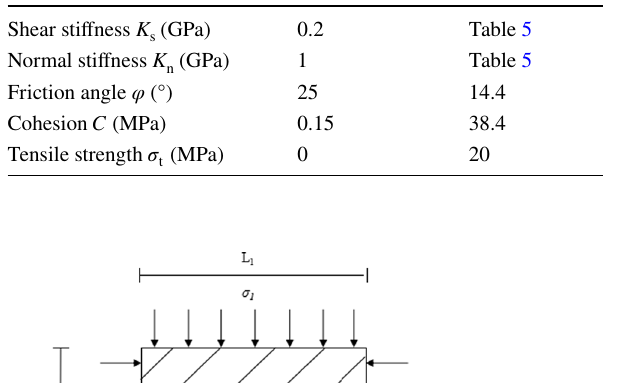
Table 4 Actual and fictitious joint parameters Mechanical parameter